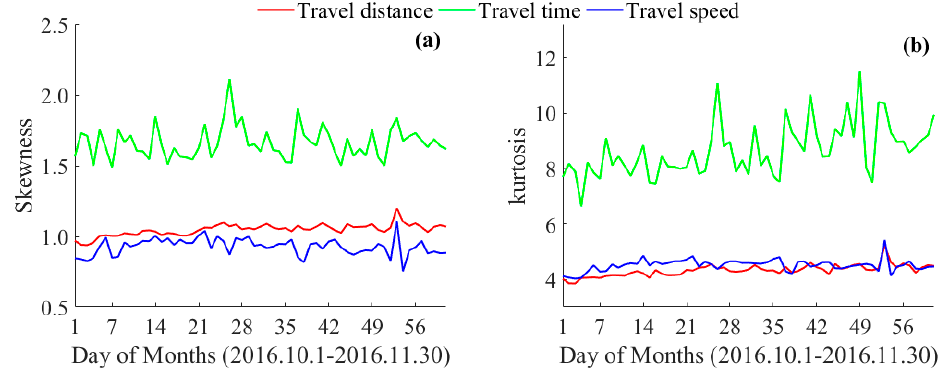
Figure 3. Daily variation of skewness and kurtosis for 61 days: ( a ) skewness; and ( b ) kurtosis Based on the above analysis, five common skewed distributions—lognormal, Gamma, Weibull, Burr, and Rayleigh—are selected as candidate distributions to fit the daily and hourly data. The probability density functions (PDF) of these distributions are defined